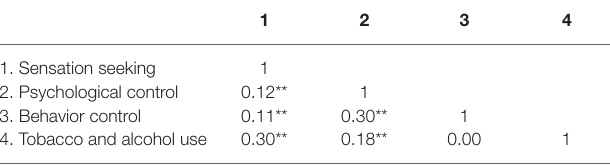
TABLE 2 | Correlations for the